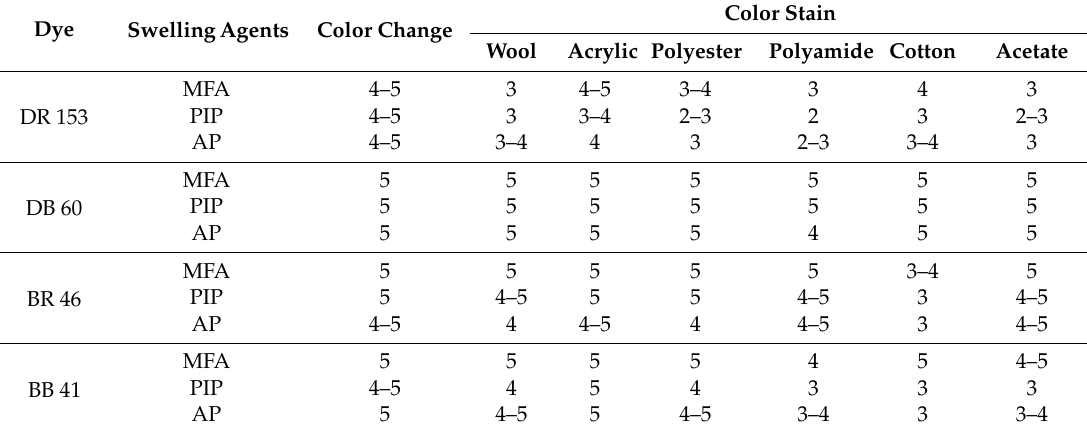
Table 3. Colorfastness to washing of PI fabrics dyed with the assistance of swelling